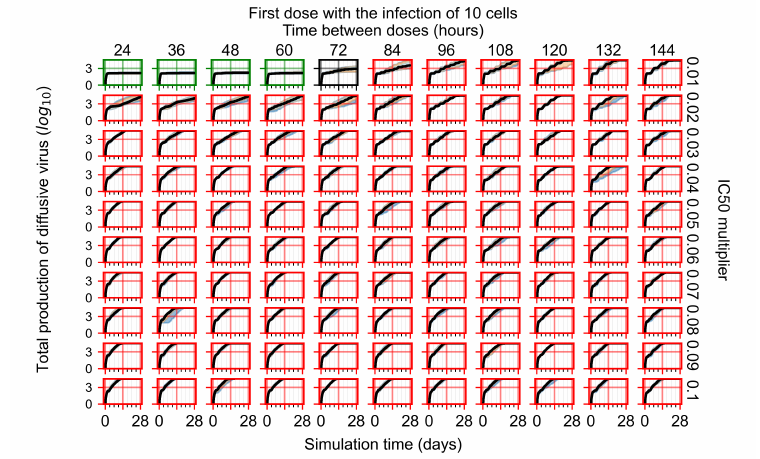
Figure A71. Total diffusive virus produced (AUC), Y axis in log scale, and exponent values as tick marks.